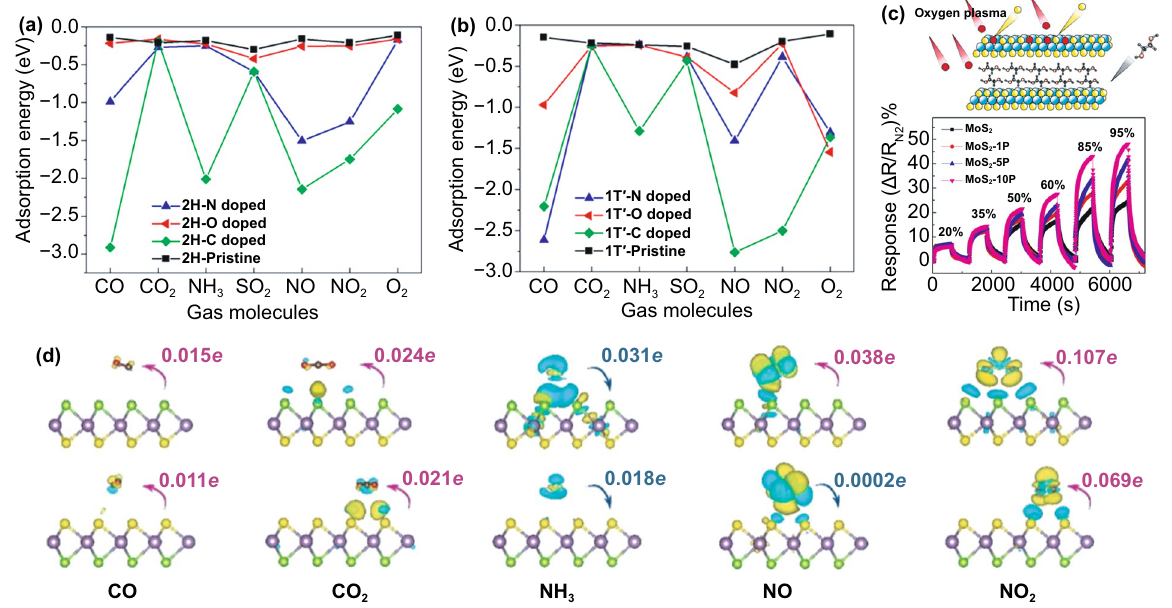
Fig. 16 Adsorption energy of gas molecules on the C-, N-, O-doped a 2H- and b 1 T-MoS 2 monolayers. Reprinted with permission from Ref. [133] Copyright 2020, American Chemical Society. c Sulfur substitution using O 2 plasma irradiation of MoS 2 and humidity sensing response values of MoS 2 irradiated by O 2 plasma. Reproduced with permission from Ref. [222]. Copyright 2020, American Chemical Society. d Charge density difference (CDD) for gas molecules adsorbed on the Se side (top panel) and S side (bottom panel). The yellow (cyan) region represents charge accumulation (depletion) and the isosurface. The orientation and the value of charge transfer of these molecules adsorbed on the Se and S surfaces are denoted. Adapted with permission from Ref. [229]. Copyright 2019 The Royal Society of